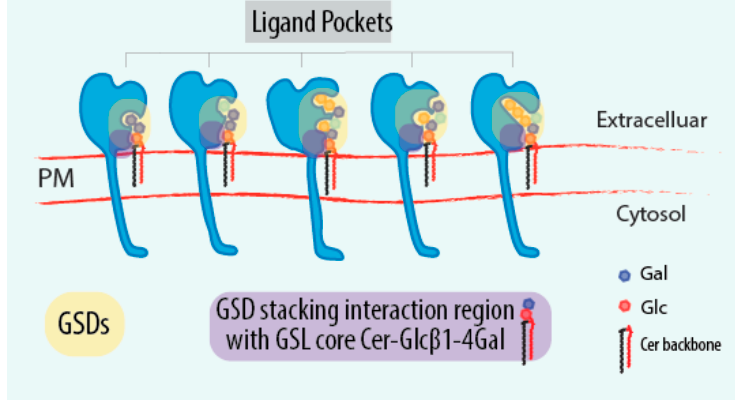
Figure 3. GSDs as sensors of the GSL-glycocode. Schematic representation of receptors containing different GSDs that recognize specificGSL-glycan portions. In light orange are highlighted GSDs in the receptors. In violet are indicated the conserved GSD portions recognizing the basic GSL core motif Cer-Glc β 1-4Gal present in the most GSLs. Coloured hexagons represent the different sugar residues of GSL-glycan moieties. Blue hexagon, Gal residue; Red hexagon, Glc residue; Black-Red parallelogram, Cer backbone; GSD, glycosphingolipid sensing domain; PM, plasma membrane.